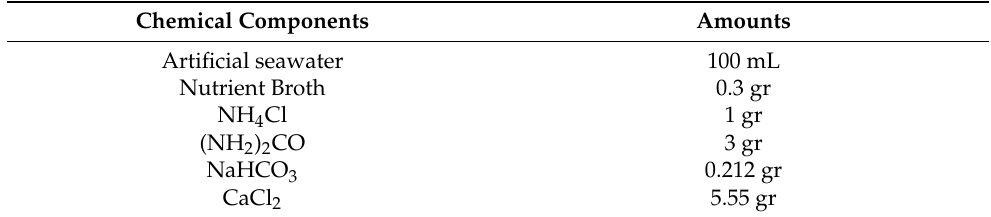
Table 2. Chemical composition of a 0.5 M solidification solution used during the artificial beachrock